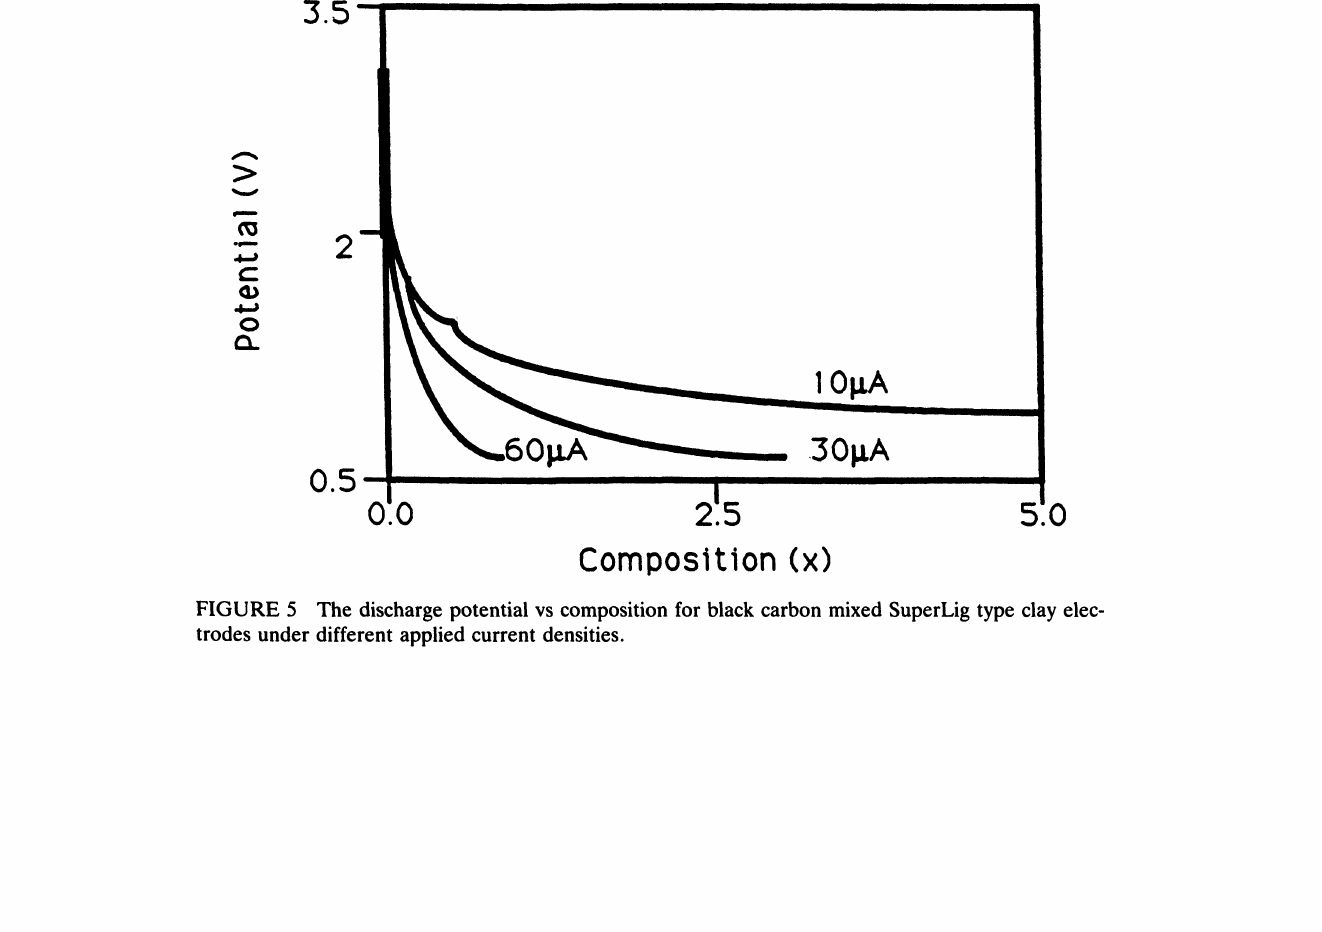
FIGURE 4 The discharge potential vs composition for black carbon mixed 13X type zeolite electrodes under different applied current densities.